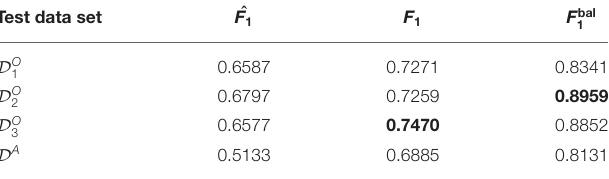
TABLE 7 | The results of the leave-one-set-out inter-set study with a small concept update in Experiment E: ˆ F 1 and F 1 scores obtained from training a ResNet-34 on three of the four data sets and approximately 20% of the fourth, and testing it on the remaining samples of the fourth data